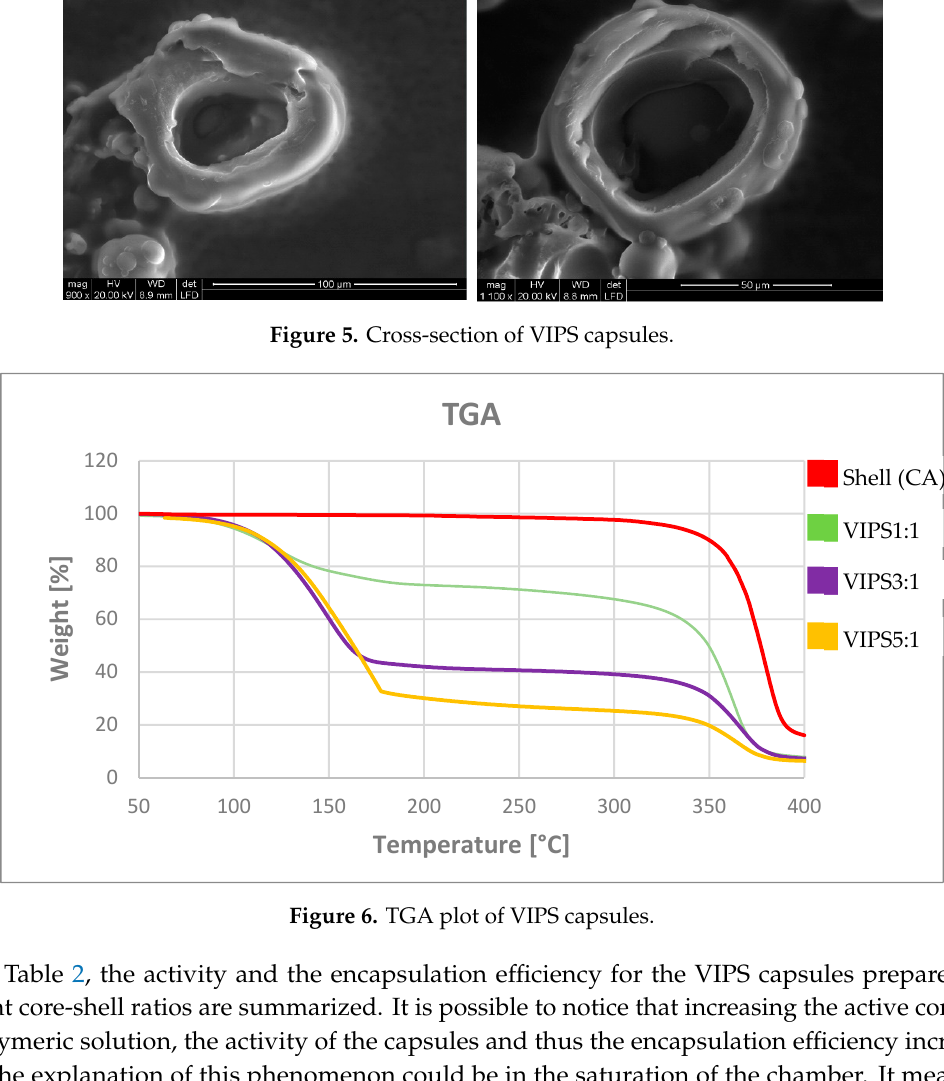
Table 2. Activity and encapsulation efficiency of VIPS capsules.